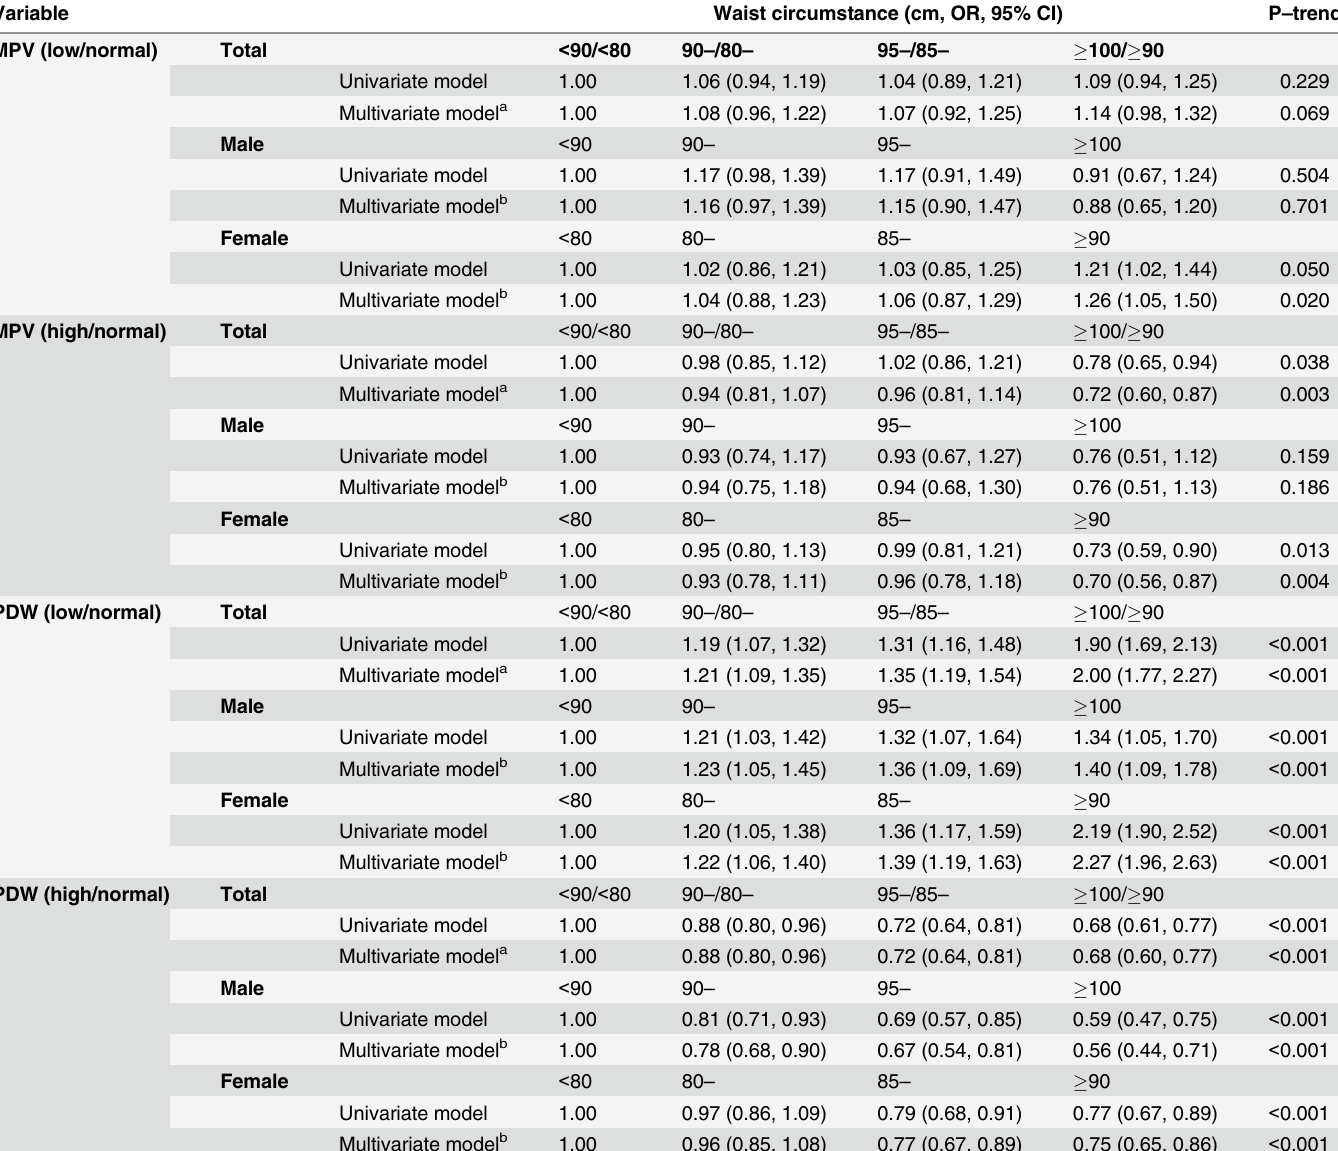
Table 3. Association between waist circumstance values and platelet indices among 17327 participants.